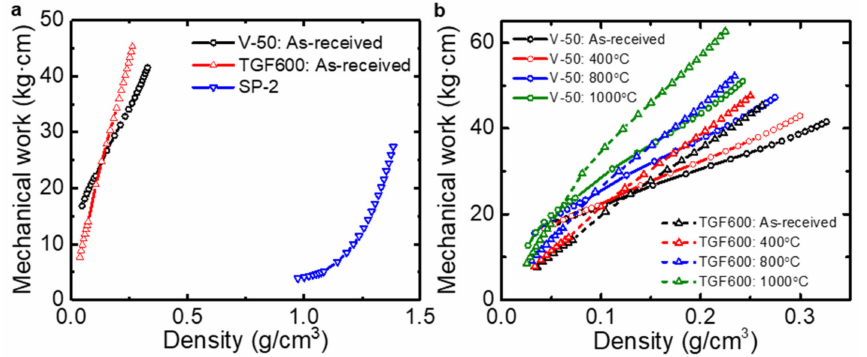
Figure 8. ( a ) Mechanical works of the graphite and rGO powders as a function of the density. ( b ) Mechanical works for rGO powders annealed at di ff erent